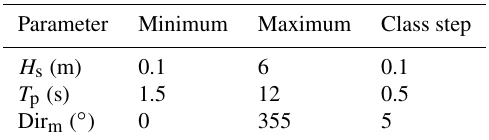
Table 3. Class properties applied to the wave parameter data sets for scenarios’ definition.